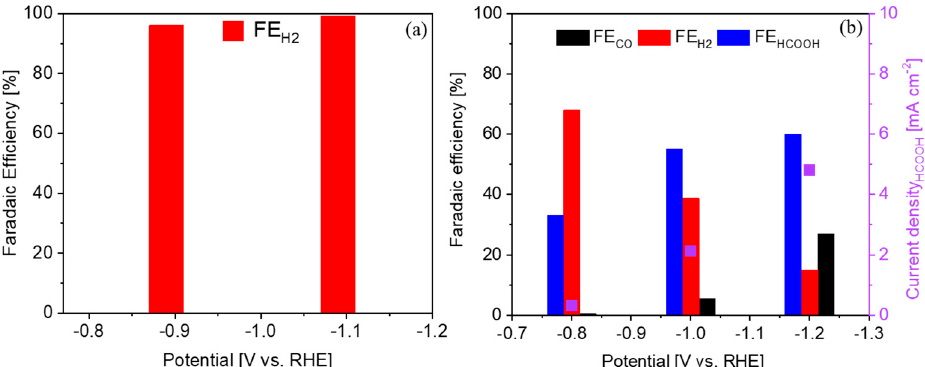
Figure 6. CO 2 RR on the electrodes in 0.1 M KHCO 3 electrolyte in a batch cell: ( a ) faradaic efficiency of the main product on the bare biochar electrode and ( b ) faradaic efficiency of the main products and partial current density for HCOOH formation on the biochar-Bi 2 O 3 electrode.